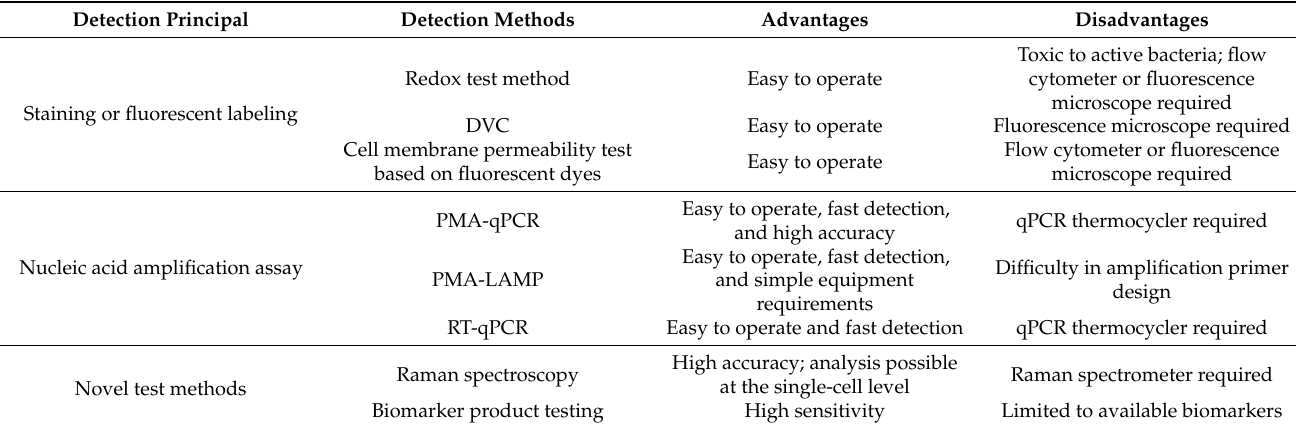
Table 2. Advantages and disadvantages of VBNC detection